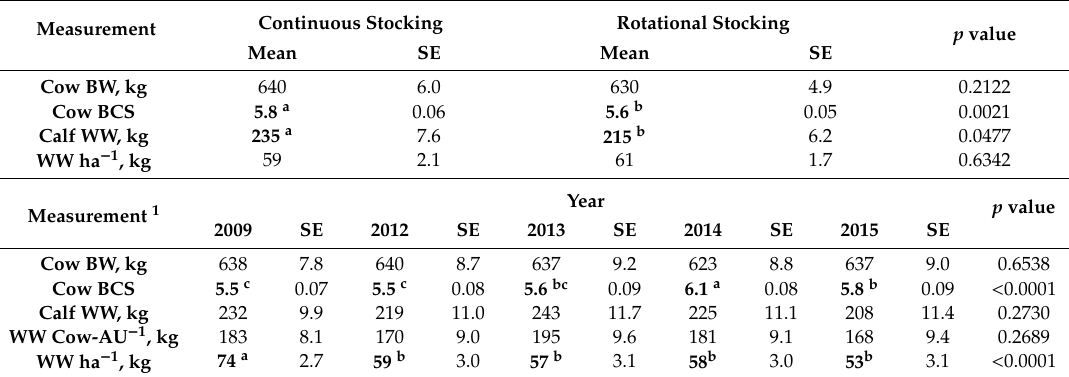
Table 5. E ff ect of grazing system (GS) and year on cow body weight (BW), body condition score (BCS), calf weaning weight (WW), WW per cow AU, and WW per